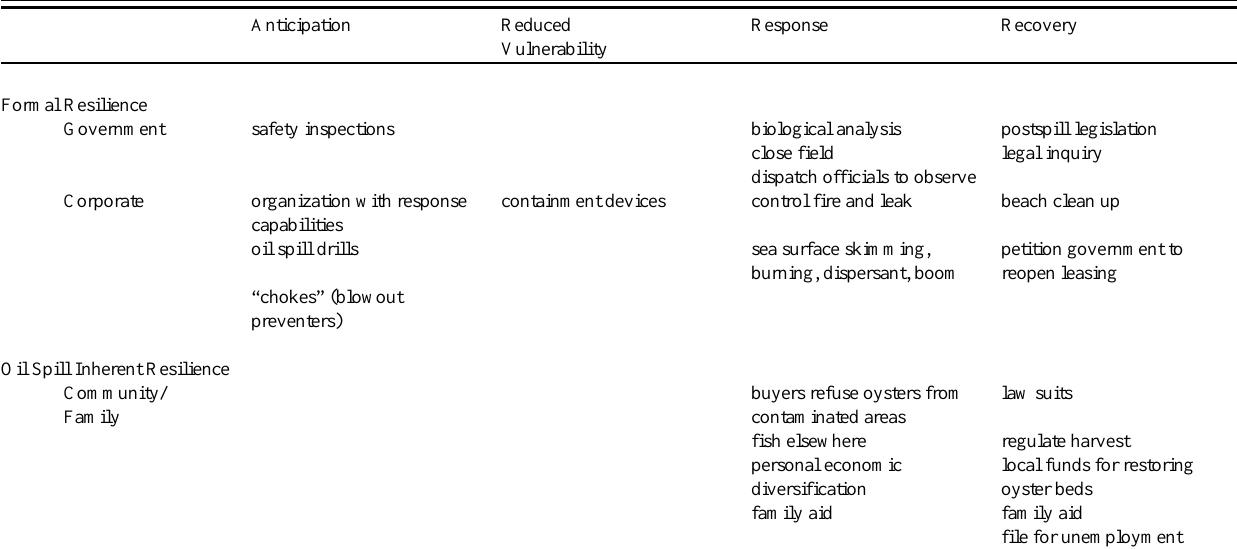
Table 2 . Pre-1972 oil spill